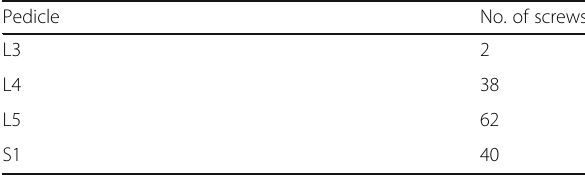
Table 2 Pedicles used and numbers of screw for each pedicle Pedicle No. of screws